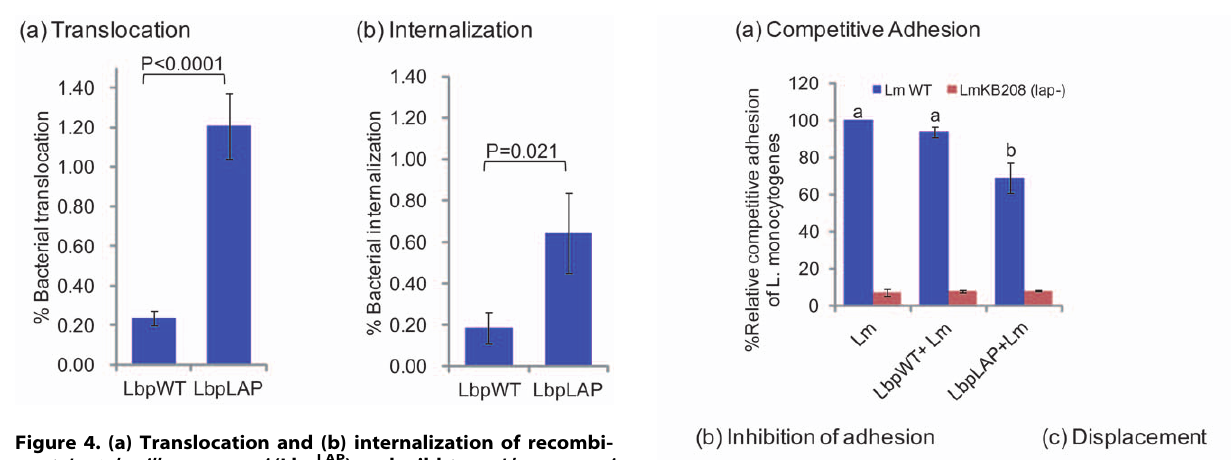
Figure 4. (a) Translocation and (b) internalization of recombi- nant Lactobacillusparacasei (Lbp LAP ) and wild type Lb.paracasei (Lbp WT ). In the translocation assay, Caco-2 cells were grown on transwell filter inserts for 10–12 days to differentiate and to reach confluence. Bacteria were added to the apical well of the insert and incubated for 2 h. Liquid from the basal well was removed and plated